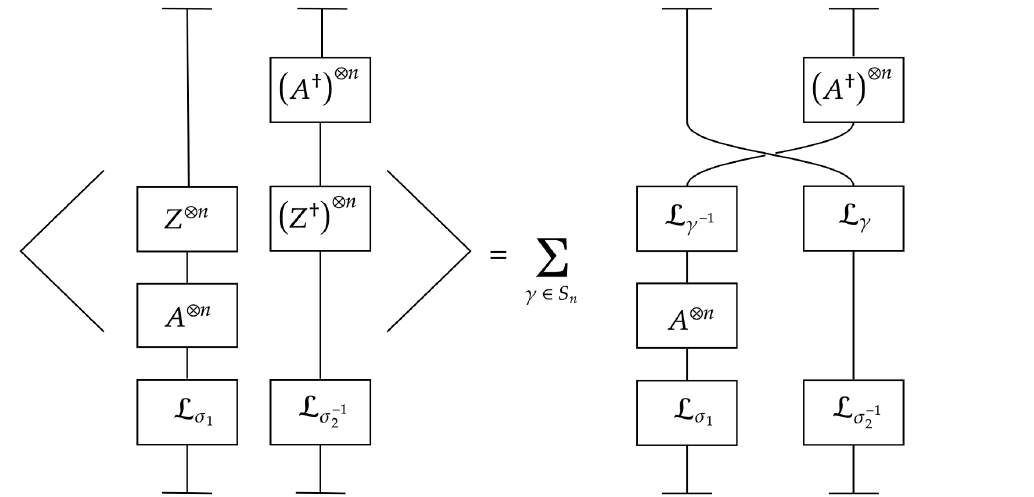
Figure 4 . The diagrammatic representation of the one-matrix, two-GIO correlator where the witness field is a classical matrix. This matrix is introduced as A (along with its conjugate A † ) and subsequently used to define B = A † A . The right hand diagram shows how upon Wick contracting, the L γ , L , operators are incorporated and the indices are γ − 1